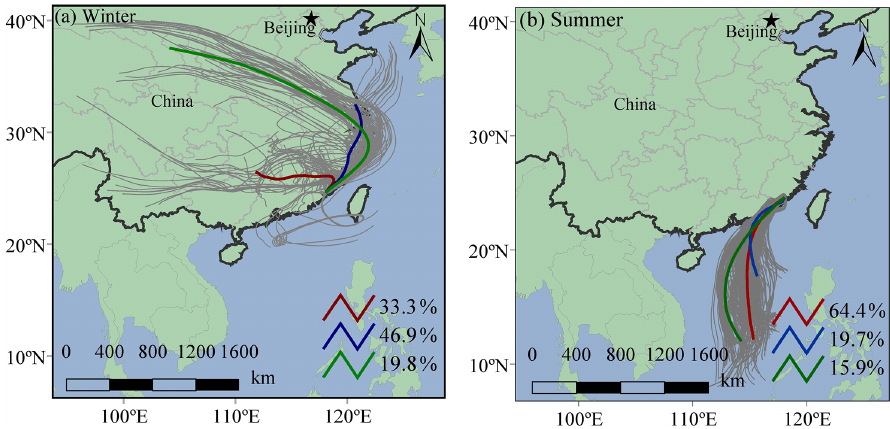
Figure 6. Backward trajectories analyses during the winter (a) and summer (b)